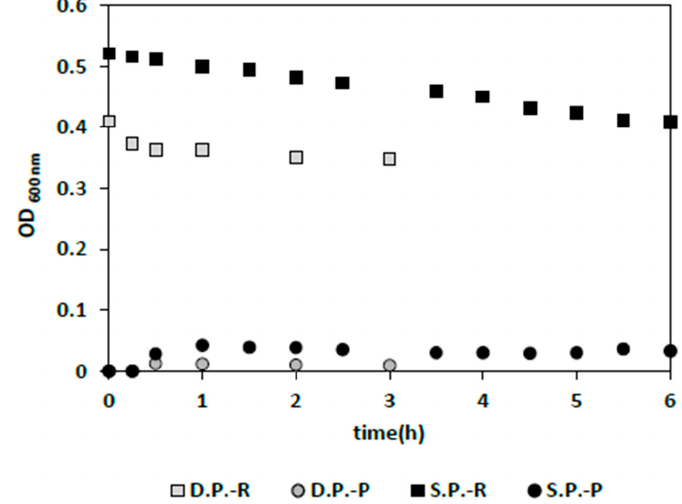
Figure 7. The effect of membrane area on filtration performance and bacterial washout in a mixed culture: Changes in the turbidity of the reactor (R) and permeate line (P) using a single (S.P.) or double (D.P.) IPC panel with the same initial permeate flux.